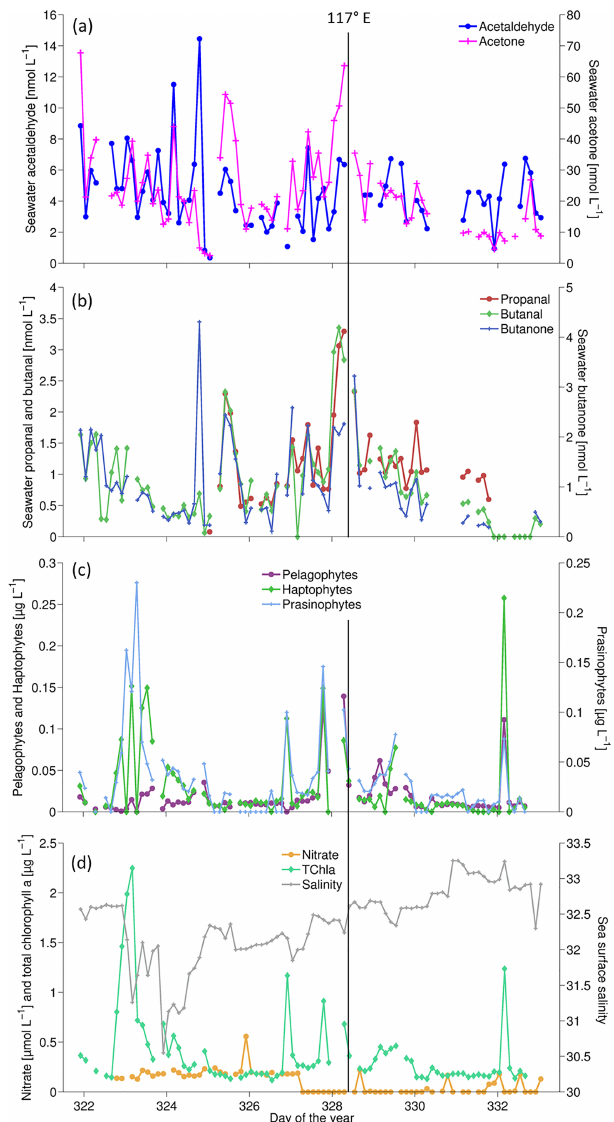
Figure 2. OVOC concentrations ( a, b ) in water, c the phytoplank- ton groups pelagophytes, haptophytes (mainly Phaeocystis sp.) and prasinophytes, d nitrate, total chlorophyll a (TChla) and salinity plotted against the day of the year (DOY). The location of the data points can be deduced from Fig. 1. The vertical line shows the location of the Balabac Strait (117 ◦ E), where coastal conditions changed to open-ocean